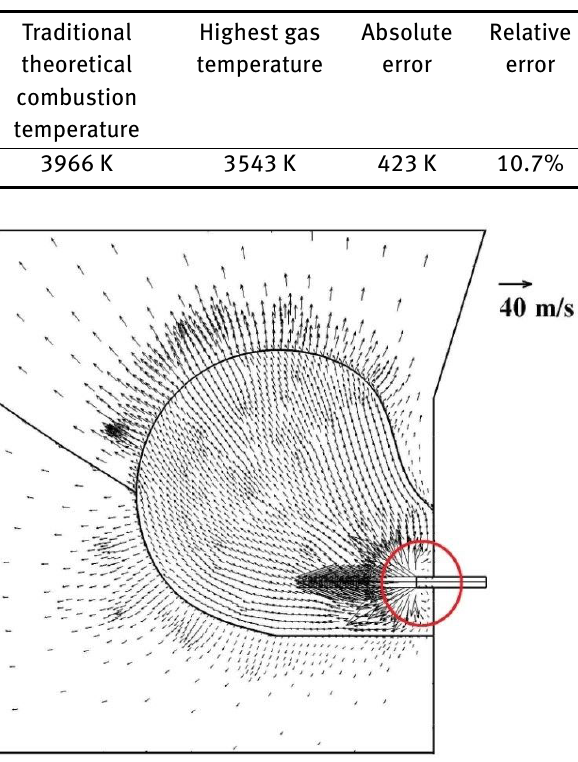
sists of graphite and amorphous carbon, so its effective for- mation enthalpy is −1.2×10 7 J/kmol [15]. (4) The void frac- tion of moving bed, deadman and raceway is set as con- stant and instead of changing as the solid descends. (5) The coke flow velocity is fixed, and its residence time in- side the deadman is 24 times more than that in the moving bed [24].